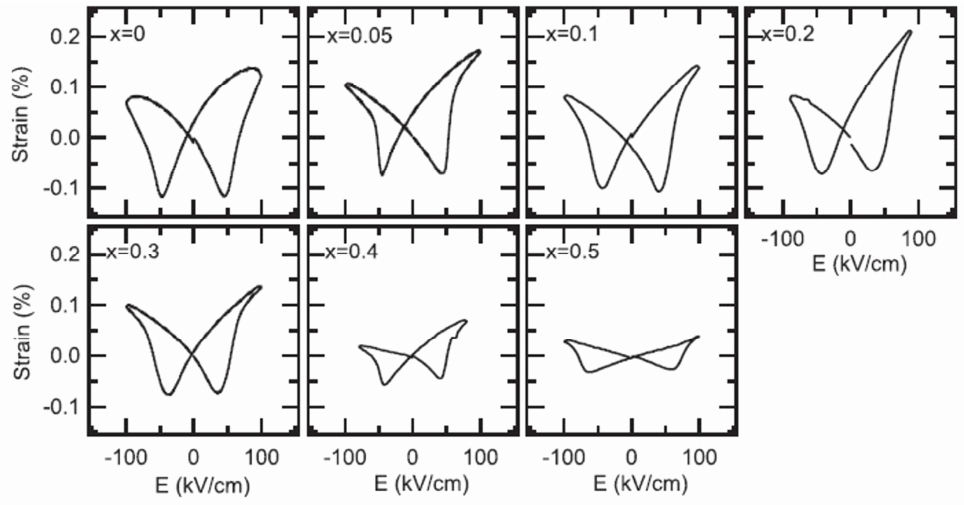
Figure 6. Bipolar piezoelectric response of (1 − x )(Bi 0.5 Na 0.5 )TiO 3 – x BiFeO 3 ceramics. Reprinted with the permission of [69]. Copyright © 2016, The Materials Research Society.